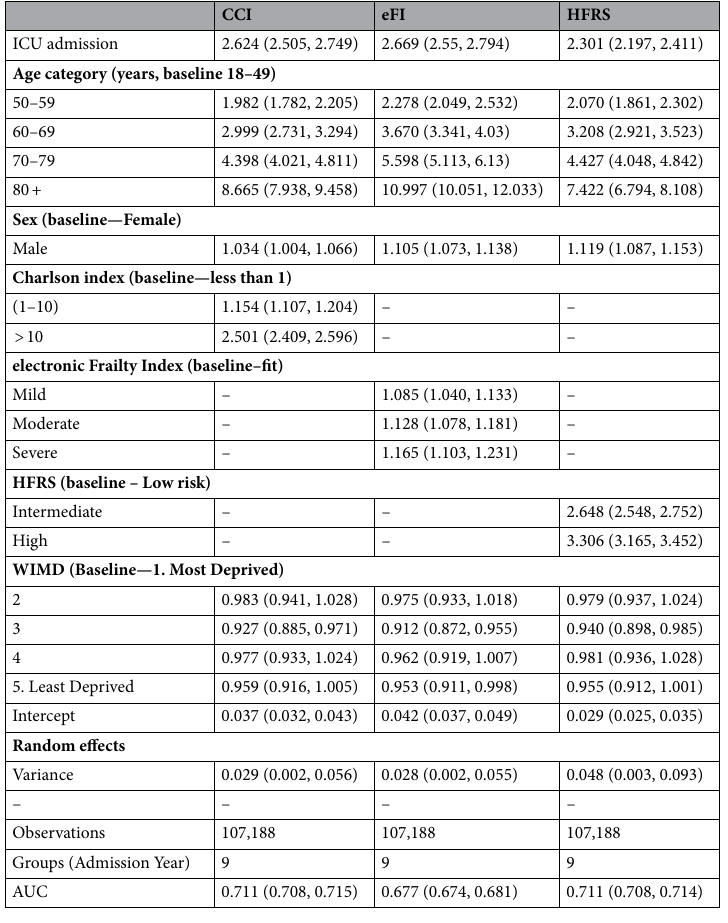
Table 2. Odds Ratios (ORs) for the adjusted multilevel multivariate logistic regression inpatient mortality analyses. ICU Intensive Care Unit; CCI Charlson Comorbidity Index; eFI electronic Frailty Index; HFRS Hospital Frailty Risk Score; WIMD Welsh Index of Multiple Deprivation 2019; AUC Area Under the